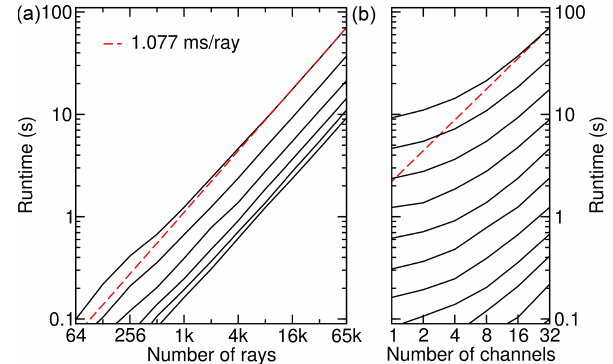
Figure 12. Scaling of the CPU runtime with respect to the numbers of ray paths. See the caption of Fig. 11 for a more detailed explana- tion. Mind the different scales.